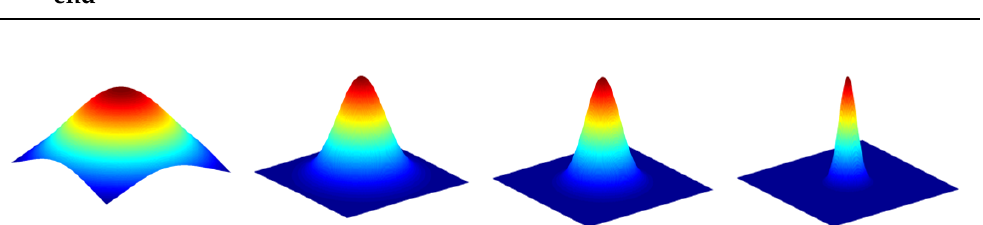
Figure 3. Effect of Shaping Parameter for α = 1, 5 10, and 40,